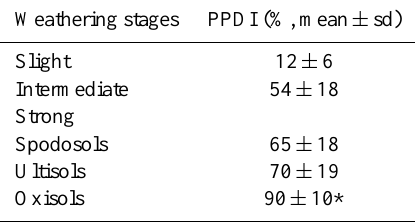
Table 2. Average PPDI (phosphorus pedogenic depletion index) for three soil weathering stages (based on Table S1). PPDI is an esti- mate of the accumulated loss of parent material P during pedogen-